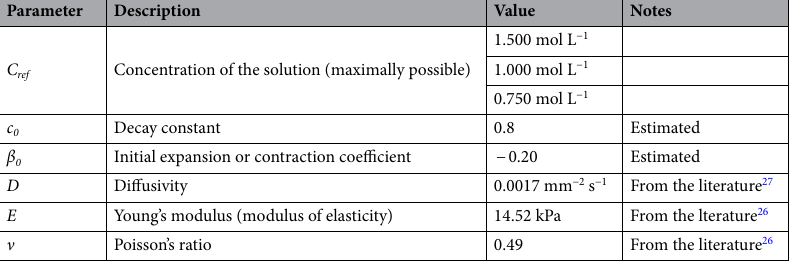
Table 2. Parameters and coefficients used in FEM